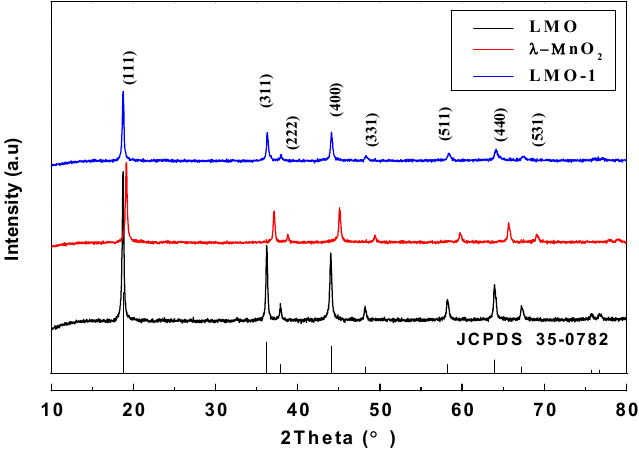
Figure 4. XRD patterns of optimized LMO, HMO and LMO-1.